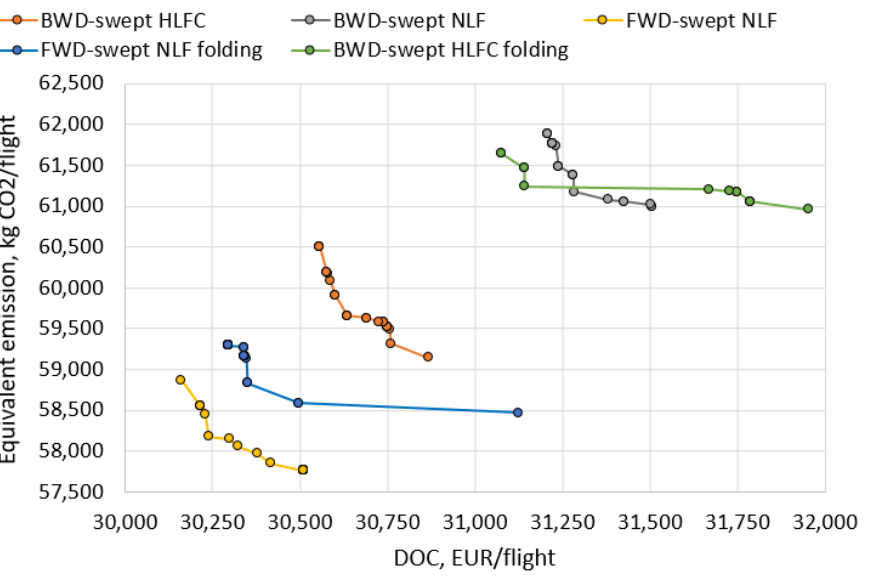
Figure 12. Summary of MDO studies for several design